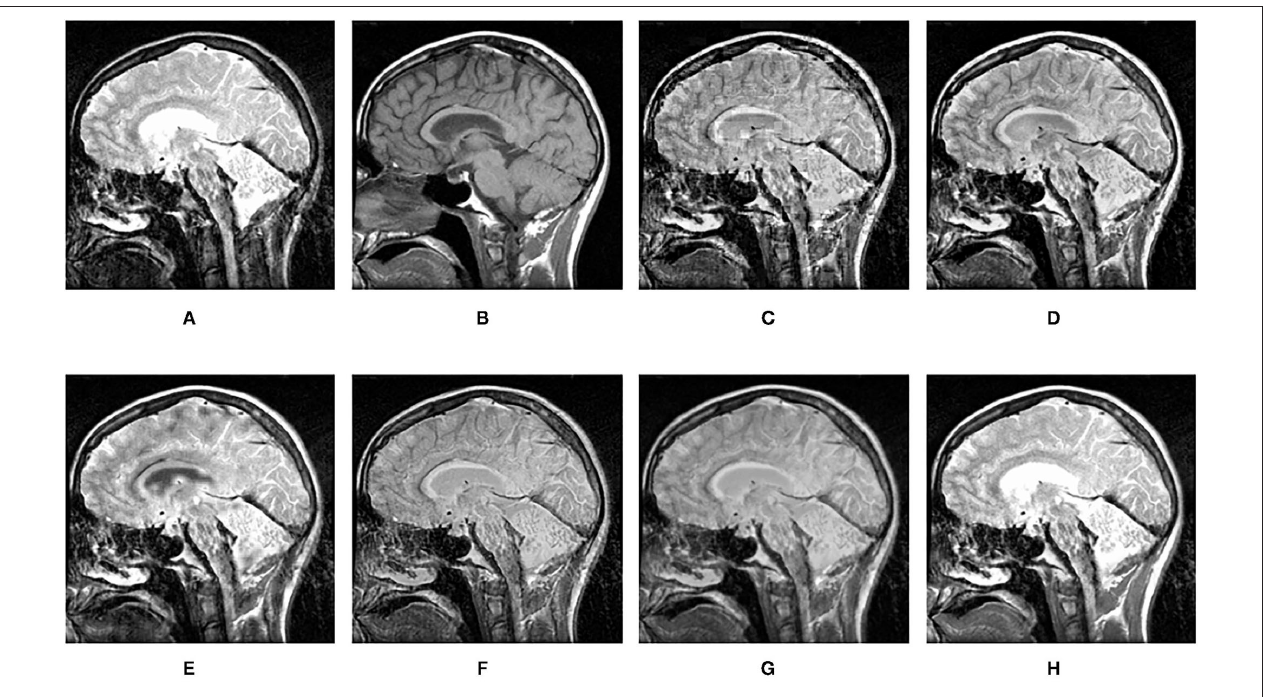
FIGURE 13 | Comparison experimental results of CT and MRI images. (A) original image (CT); (B) original image (MRI); (C) DWT; (D) LP; (E) SR; (F) DTCWT-SR; (G) VGG; (H) MPS.